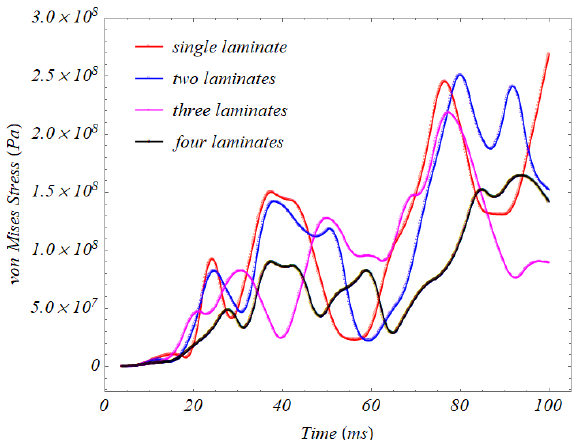
Fig. 19. von Mises stress against time for various number of cellphone casing laminates at 2000 mm drop distance.